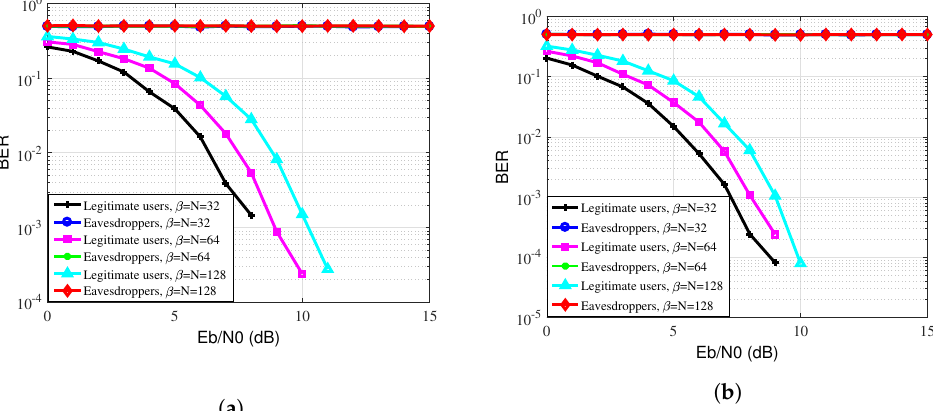
Figure 5. BER of legitimate users and eavesdroppers over AWGN channel. ( a ) BER over the AWGN channel with BPSK; ( b ) BER over the AWGN channel with QPSK.